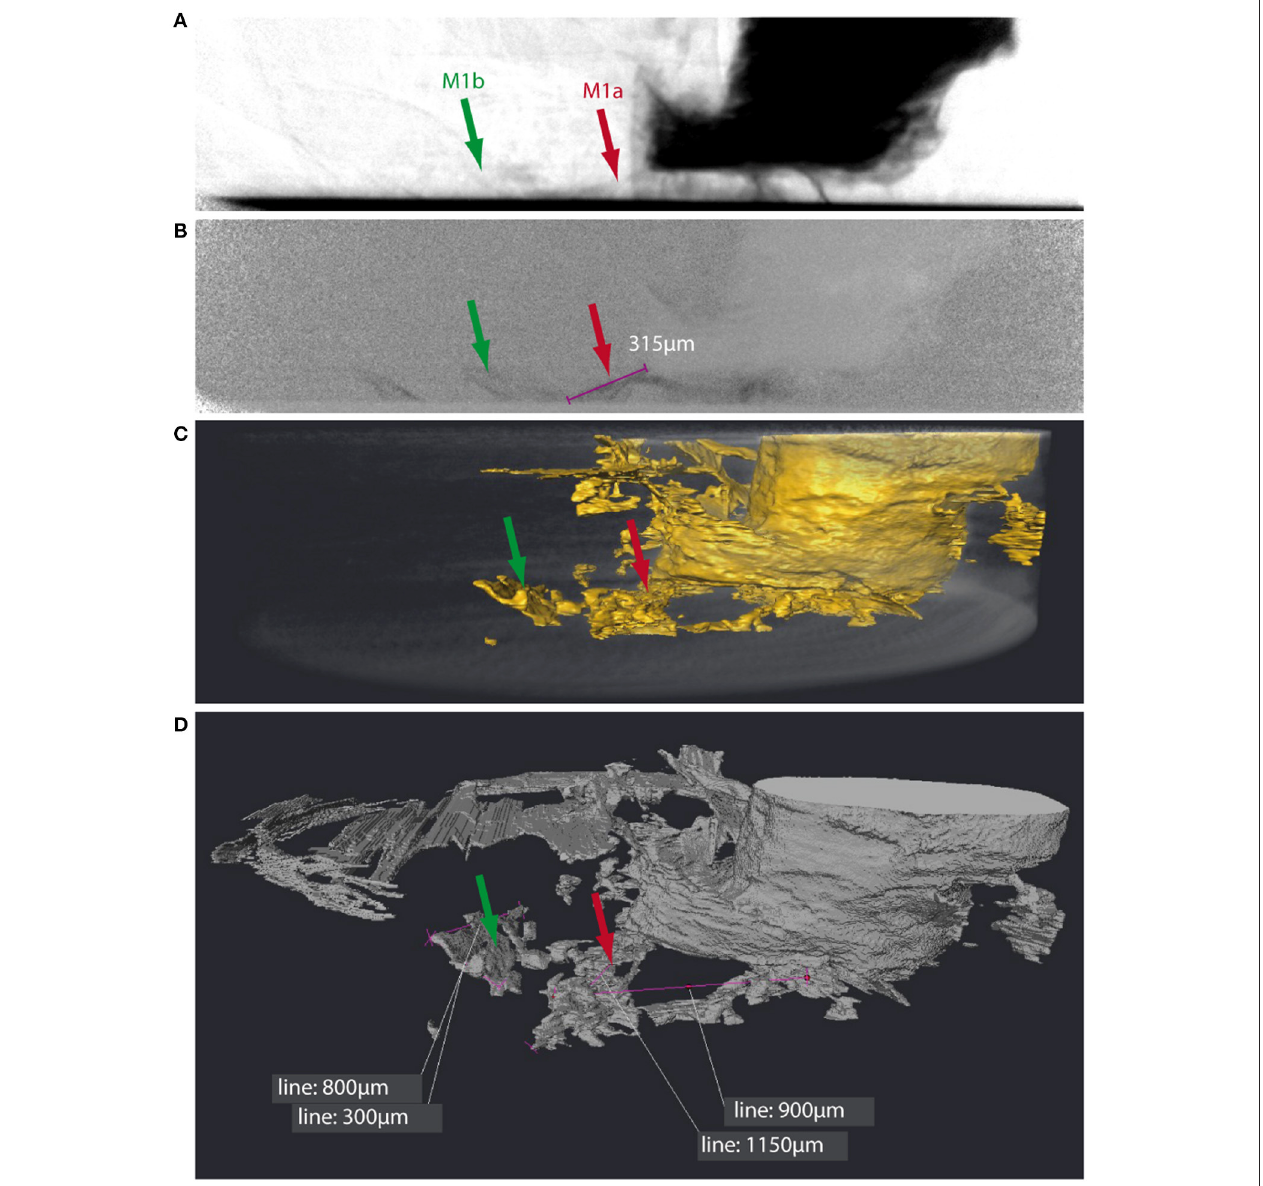
FIGURE 8 | Matching melt migration observed in 2D radiograms to 3D tomographic reconstructions of the existing fracture network. Panels (A,B) are radiographic projections (p x ) and difference projections (p x -p 0 ), respectively, from the time series shown in Figure 5 , with areas of interest marked, representing an episode of melt movement, and estimated distance for the minimum path length the melt has taken based on 2D images, shown in purple. This movement occurred between two projections (i.e., < 20s). (C) 3D reconstruction of the sample after heating, with arrows indicating end points for melt movement. (D) Measurements made using Avizo Fire TM “3D Measure” tool showing estimated displacement of paths taken along the 3D fractures (voxel size ∼ 2.8 µ m). Due to partial volume effects and